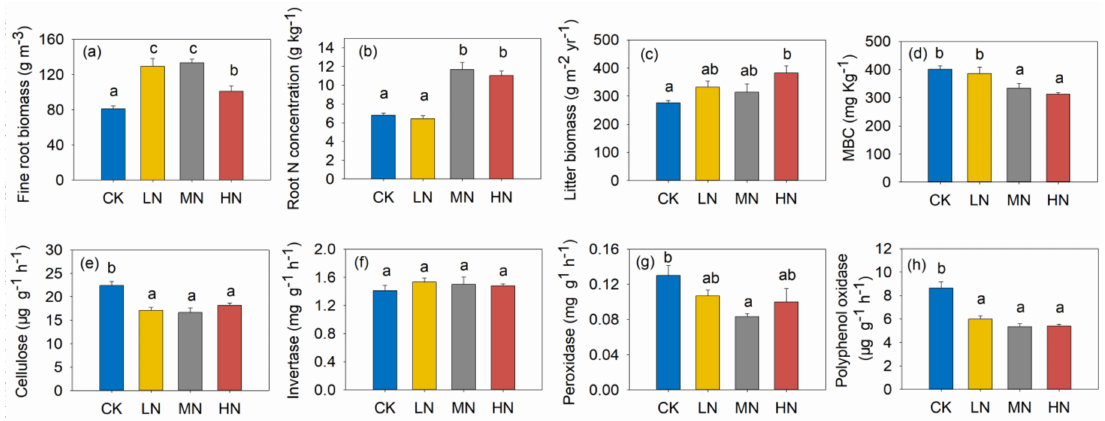
Figure 4. Responses of ( a ) fine root biomass, ( b ) fine root N concentration, ( c ) litter biomass, ( d ) microbial biomass C, and ( e – h ) soil enzyme activity to 5-years of N addition in the Pinus tabulaeformis forest. Different letters on the top of bars represent significant differences ( p < 0.05). Data are mean ±